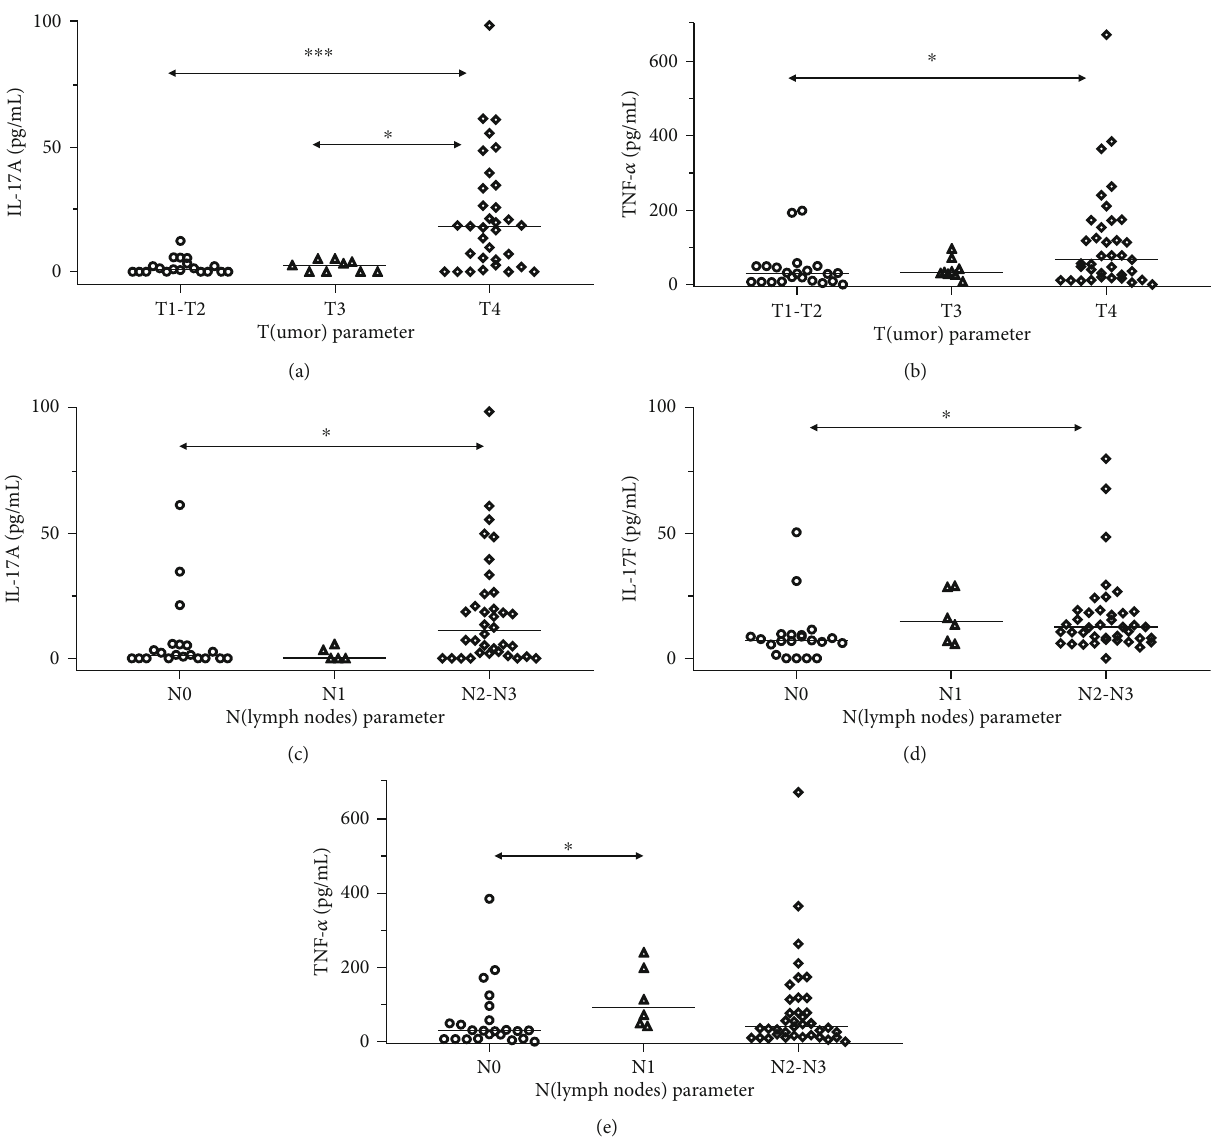
Figure 2: Di ff erences in concentrations of IL-17A, IL-17F, and TNF- α between patients with head and neck cancers depending on T or N parameters. (a) There was a signi fi cant di ff erence in salivary concentration of IL-17A ( p < 0 : 001 ) between patients with di ff erent sizes of primary tumor; post-hoc tests showed signi fi cant di ff erences between stage T4 patients and T1-T2 as well as T3 patients. (b) There was a signi fi cant di ff erence in salivary concentration of TNF- α ( p < 0 : 05 ) between stages and post hoc tests showed signi fi cant di ff erences between stage T4 patients and T1-T2 patients. (c) There was a signi fi cant di ff erence in salivary concentration of IL-17A ( p < 0 : 01 ) between stages and post hoc tests showed signi fi cant di ff erences between N2-N3 patients and N0 patients. (d) There was a signi fi cant di ff erence in salivary concentration of IL-17F ( p < 0 : 05 ) between stages, and post hoc tests showed signi fi cant di ff erences between N2-N3 patients and N0 patients. (e) There was a signi fi cant di ff erence in salivary concentration of TNF- α ( p < 0 : 05 ) between stages, and post hoc tests showed signi fi cant di ff erences between N1 patients and N0 patients. ∗ p < 0 : 05 , ∗∗∗ p < 0 : 001 ,